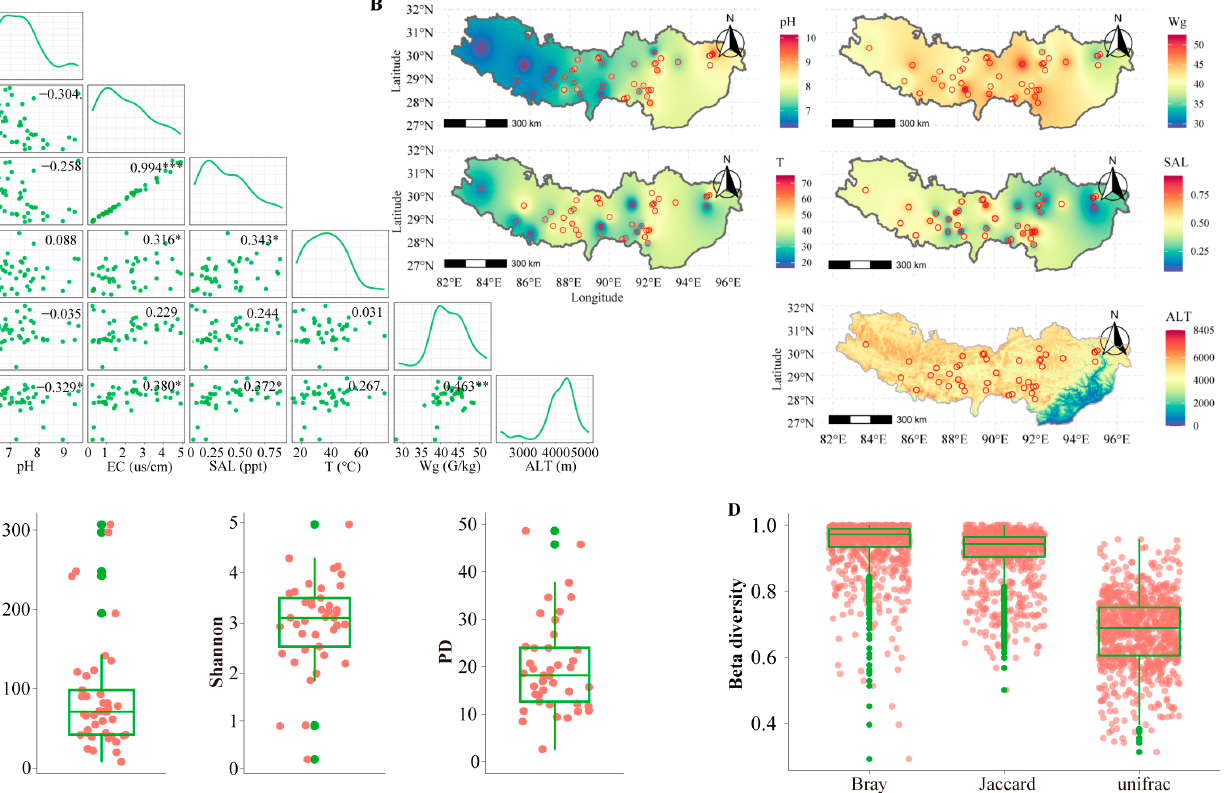
Figure 2. High variation in environmental factors and diversity of protists. ( A ) Spearman correla- tions among environmental factor parameters. ( B ) The spatial patterns of environmental factors. ( C ) Richness, Shannon, and PD index of protists. ( D ) Beta diversity of protists.